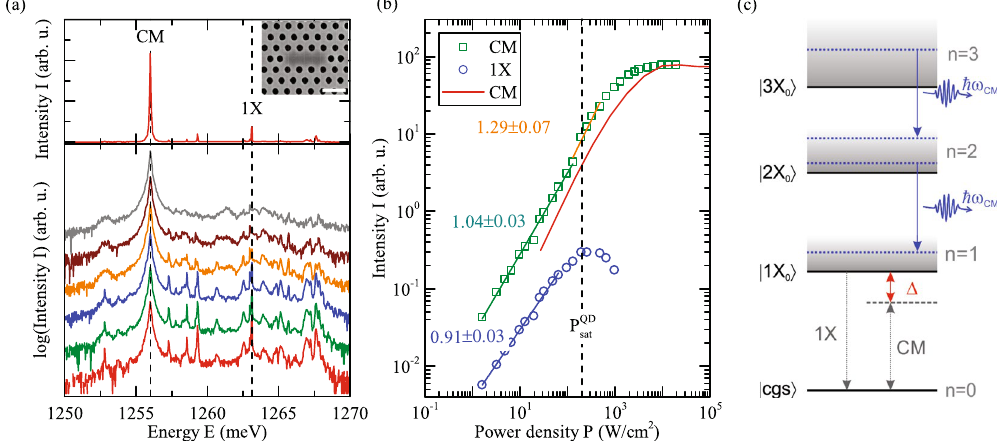
±0.03± ±0.03 Figure 1. ( a ) Photoluminescence of the QD-cavity system (upper panel) and power-dependent measurement for power densities from 0.14 kW/cm 2 to 5.9 kW/cm 2 (lower panel). The spectra are plotted on a logarithmic scale with offset to each other for clarity. The cavity mode is labeled CM, a dominant QD-transition line 1X. Inset: Scanning electron microscope image of PhC nanocavity. Scale bar, 500 nm. ( b ) Integrated intensity of the cavity mode (green) and the QD 1X line (blue) as a function of excitation power density. Solid blue and green lines are power-law fits to the emission data. The solid red line depicts the intensity of the cavity mode emission calculated from theory. To connect the theoretical pump rate with the experimental power density, the red curve has been shifted along the power axis to ensure that the calculated exciton saturation coincides with P satQD . ( c ) Schematic level scheme of the manifolds of multi-excitonic emission channels with = … n 0 3 excitations. The blue arrows indicate resonant recombination